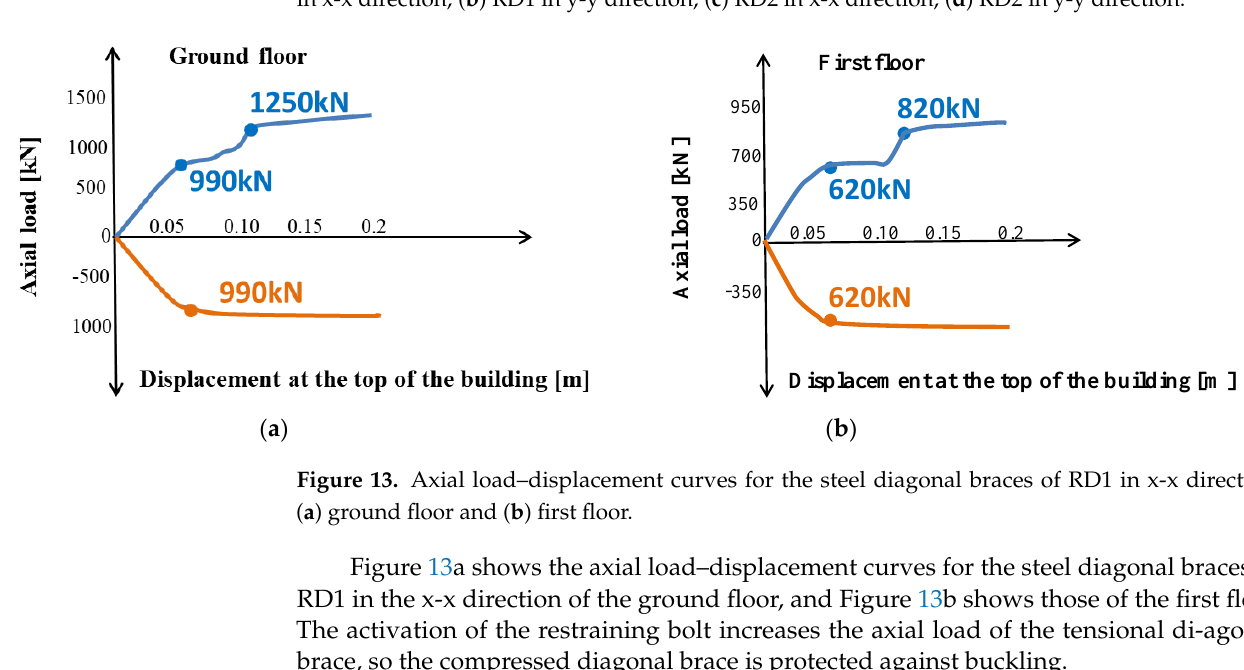
Figure 12. Plastic hinges of redesign buildings for a displacement level of 18.4 cm (at the top) ( a ) 338